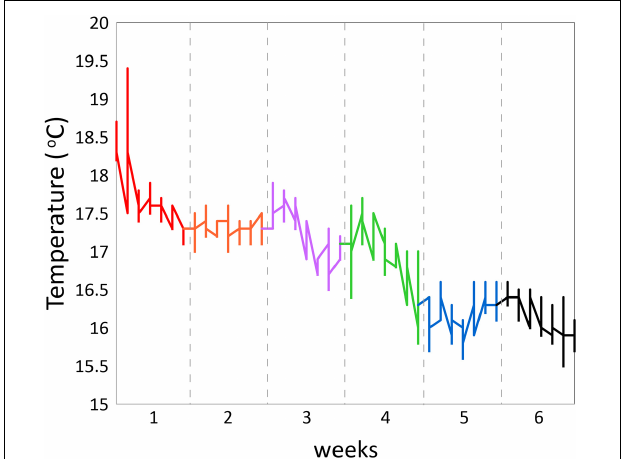
FIGURE 3 | Water temperature as measured over the experimental weeks